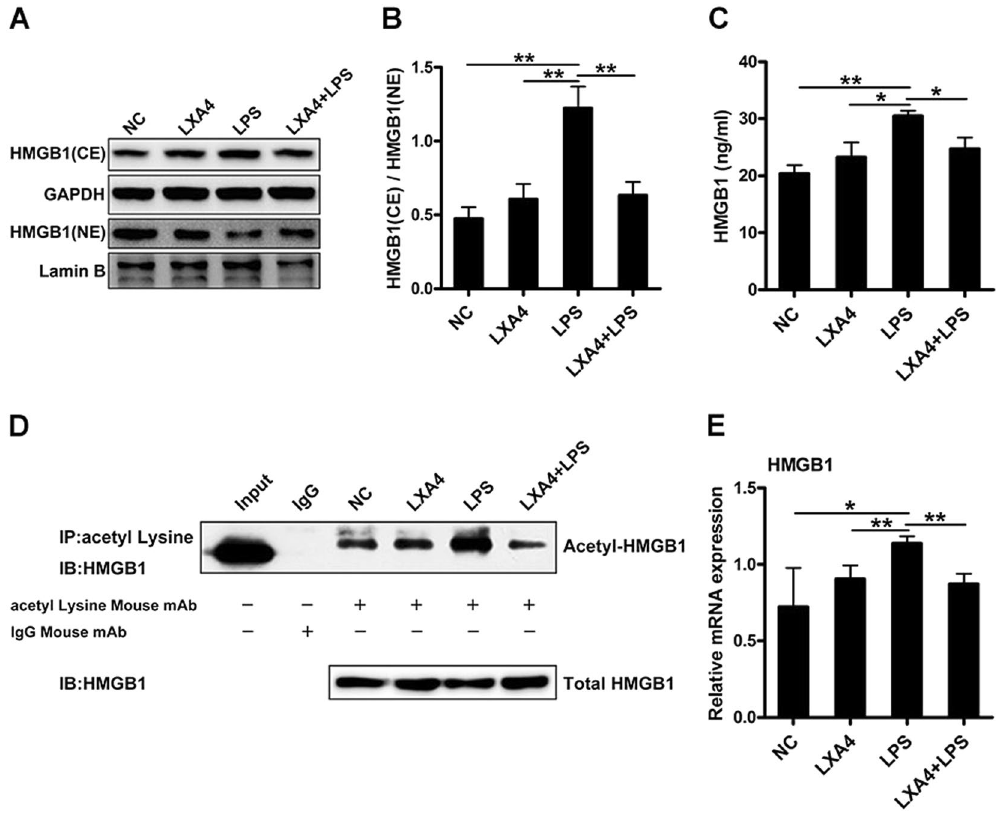
Figure 5. LXA4 pretreatment downregulates the LPS-induced secretion and expression of HMGB1 in keratinocytes. NHEKs were stimulated with LPS (10 μ g/ml) with and without preincubation with LXA4 (100 nmol/l) for 30 minutes. ( A ) Western blot analysis shows specific bands for the expression of nuclear and cytoplasmic HMGB1 in NHEKs. Full-length blots are presented in Suppl. Figure S6. ( B ) Ratio of HMGB1 expression in CE to NE was assessed by the quantification of relative optical density. ( C ) The culture supernatant of NHEKs was obtained 24 hours after LPS challenge to determine HMGB1 concentration by ELISA. ( D ) Whole cell lysates of NHEKs in the four groups were immunoprecipitated with an anti-acetyl-lysine antibody and immunoblotted for HMGB1. Anti-mouse IgG was used as a negative control. Full-length blots are presented in Suppl. Figure S7. ( E ) NHEKs were collected after LPS stimulation to determine HMGB1 mRNA levels by PCR. The results are shown as the mean ± SD. ** p < 0.01 and * p < 0 . 05 , compared to NHEKs treated with LPS without LXA4. All experiments were conducted thrice, and the representative results are